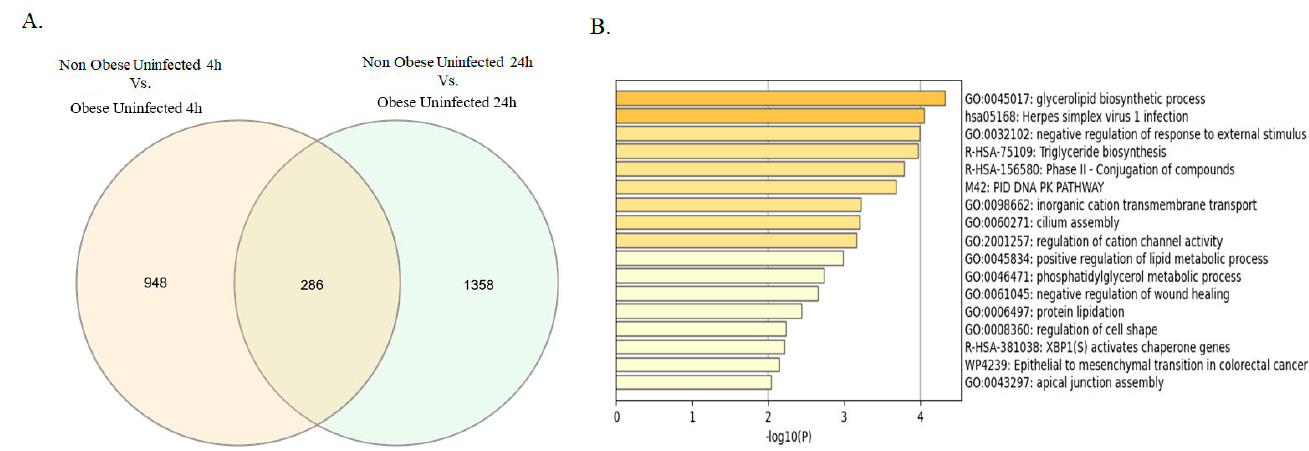
Figure 2. Differentially expressed genes between bronchial epithelial cells from non-infected non- obese and obese subjects. ( A ) Venn diagram showing the intersection of DEGs found between non- infected bronchial epithelial cells from non-obese and obese subjects at 4 and 24 h. ( B ) Enrichment analysis of intersecting genes found in Venn diagram.